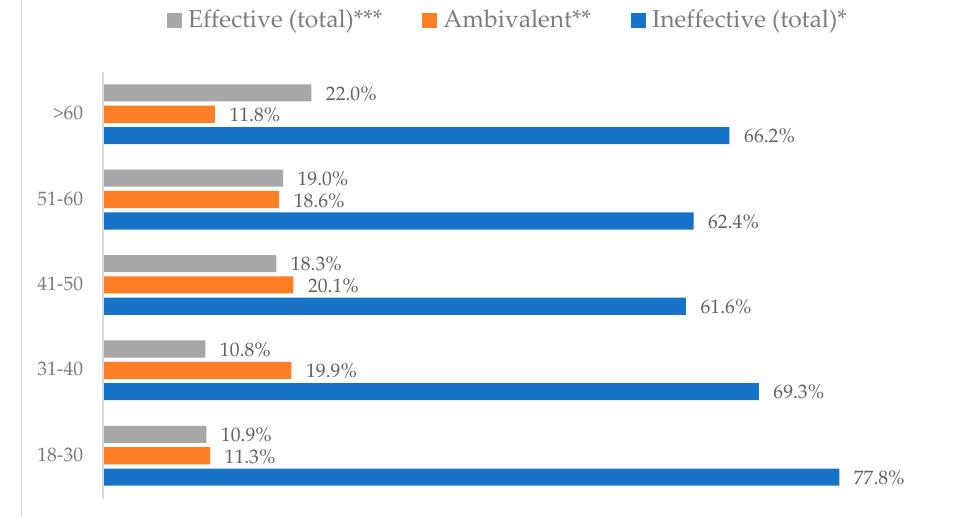
Figure 22. Eating garlic to prevent influenza virus infection by age ( N = 905). *Sum of responses: completely ineffective, ineffective, rather ineffective; **Response: neither ineffective nor effective; ***Sum of responses: rather effective, effective, completely effective.